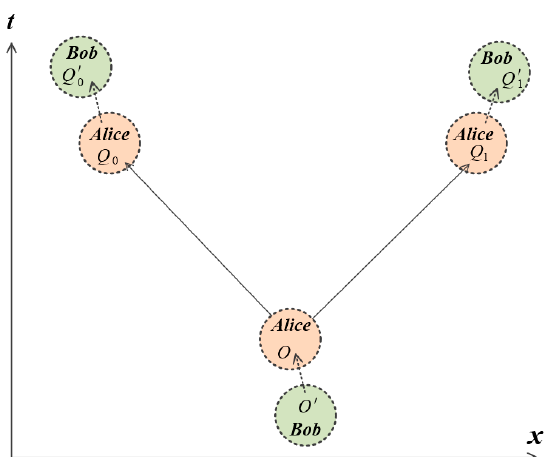
Figure 1. A nonideal implementation of the protocol. (Not to scale.) Alice and Bob control disjoint regions of space-time, representing their respective secure laboratories. Bob generates random Bell states at O (cid:48) and shares them (dashed arrow) to Alice at point O . At point O , Alice then teleports the committed qubit to Bob and transmits the teleportation measurement outcomes via secure light-speed channels (solid arrows) to her agents at the points Q i , who relay them (dotted arrows) to Bob’s agents at the nearby points Q (cid:48) i